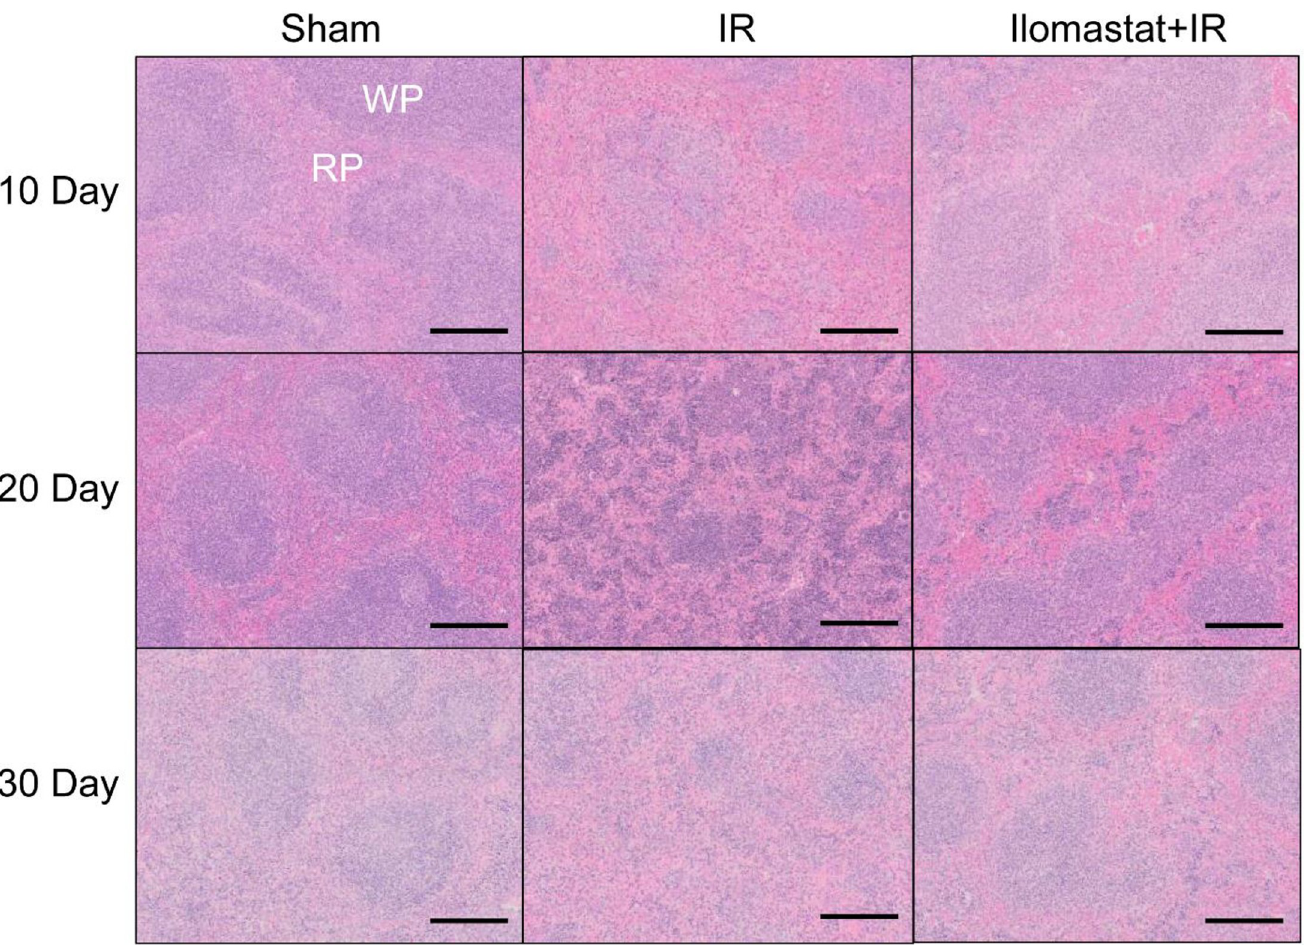
Fig 5. Ilomastat pretreatment improves the spleen’s histological recovery of irradiated mice. Mice were administrated with/without 10 mg/kg Ilomastat 2 h before exposure to 6 Gy γ -ray irradiation. H&E staining in the spleen of irradiated or unirradiated mice at day 10, 20 and 30 and the representative images were presented. Bar = 100 μ